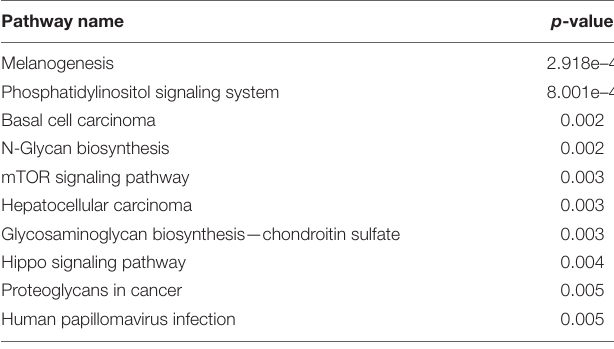
TABLE 2 | Top 10 enriched pathways between meiotically competent (PND 16 large and PND 40) and non-competent (PND 16 small and PND 13) oocytes.